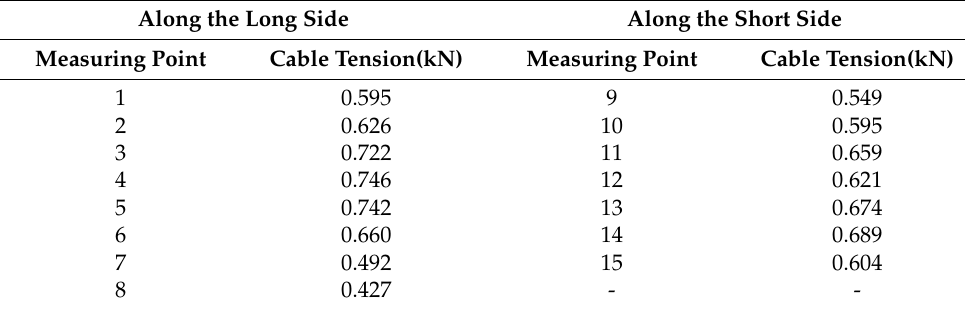
(2) Radar data processing